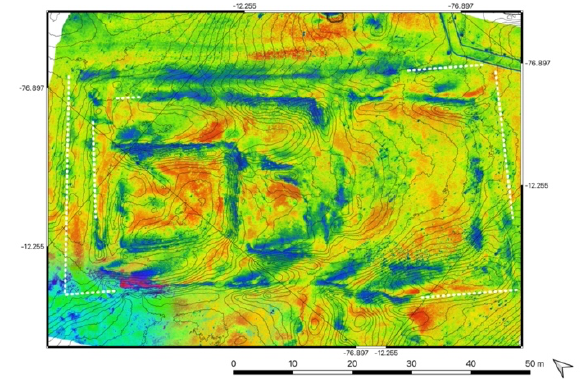
Figure 19 . Crossed results of the various surveys of building E3 with potential buried structures (white tilled